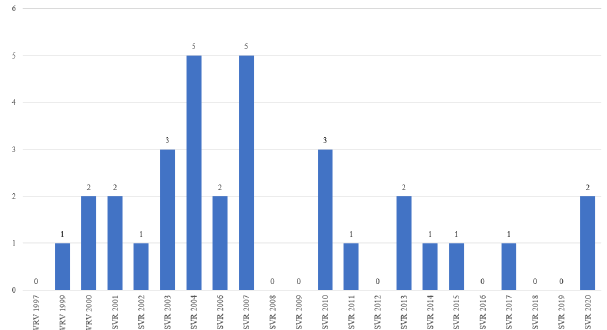
Figure 12. Overall distribution of papers from the “Virtual humans/avatars” topic.